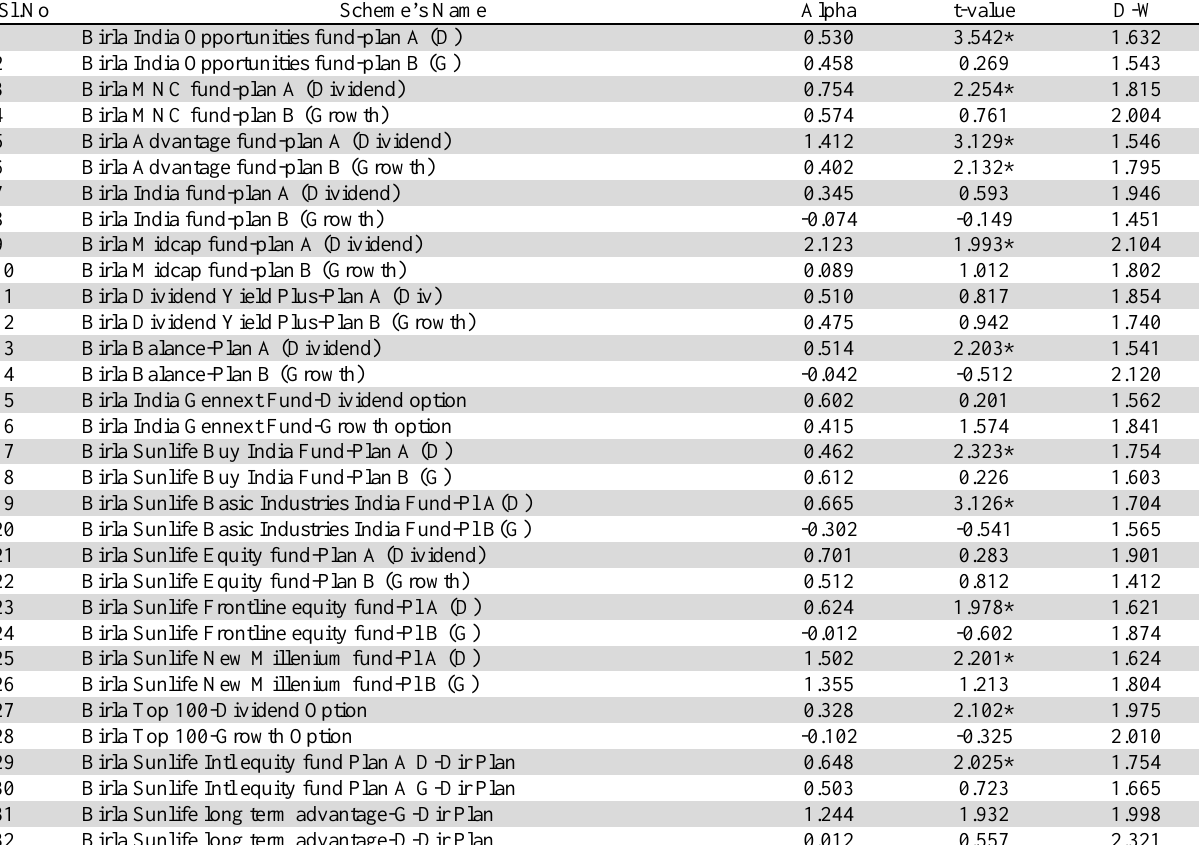
Estimation of selectivity performance based onunconditional measure